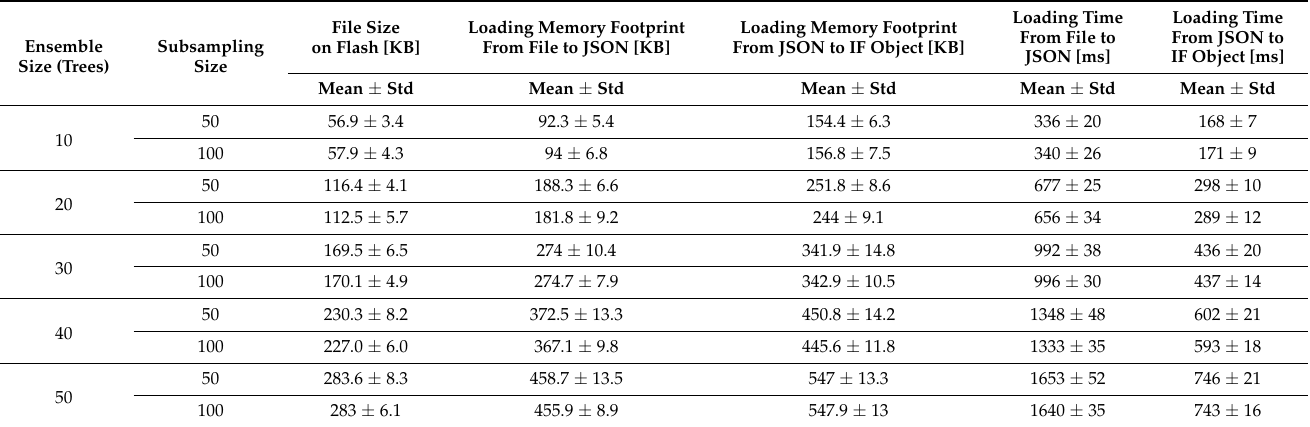
Table 3. Memory footprint (flash memory and RAM occupation) and delay of the model loading phase during the Inference